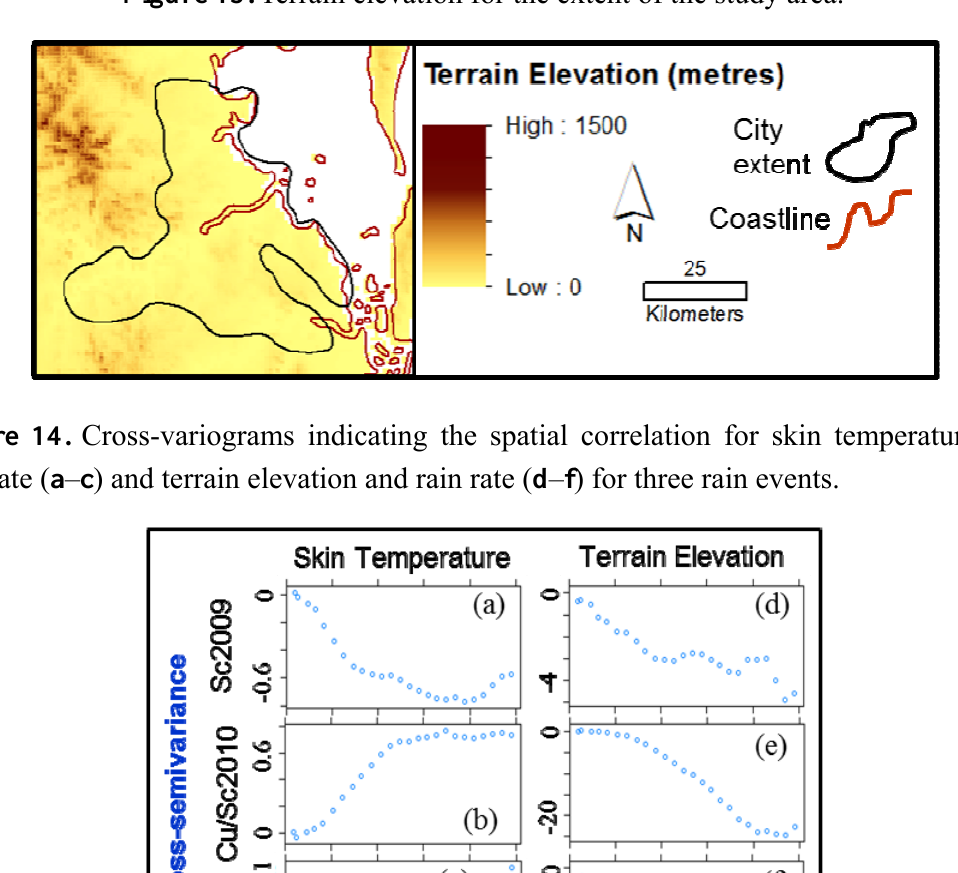
Figure 13. Terrain elevation for the extent of the study area.